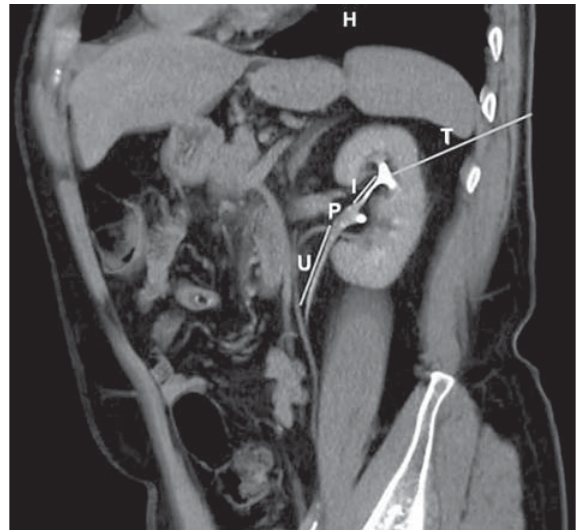
Figure 2 – Three-dimensional oblique coronal multi-planar reformatted image demonstrating a relatively straight path from the point of entry, through the infundibulum and renal pelvis and to the ureter, afforded by an intercostal posterior upper polar calyceal access, forming only a small angle with the renal